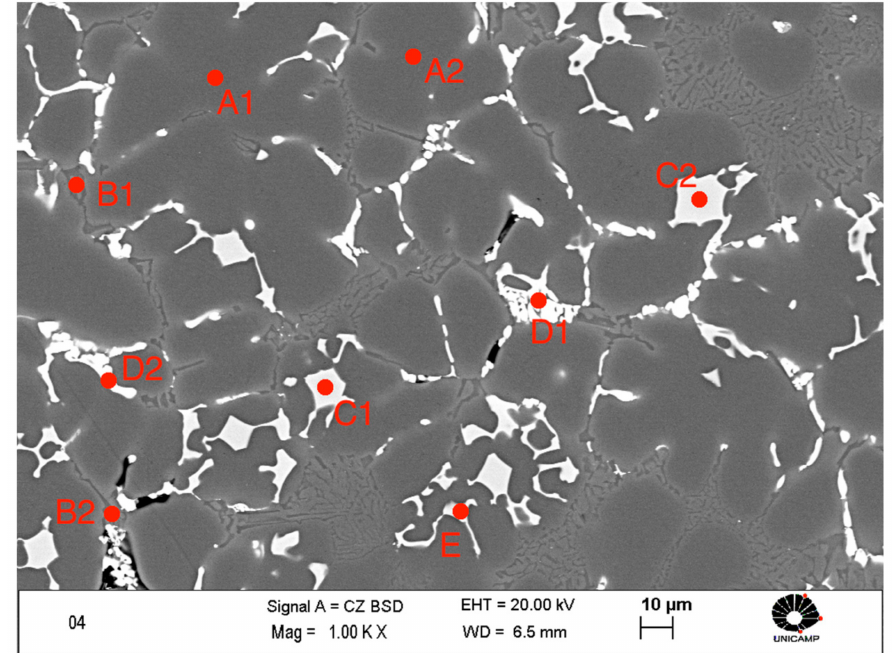
Figure 3. SE-SEM micrographs of the as-cast B319+Fe alloy showing points used for punctual chemical analysis: α -Al (points A), Al-Si eutectic (points B), α -Al 15 (MnFeCr) 3 Si 2 particles (points C),